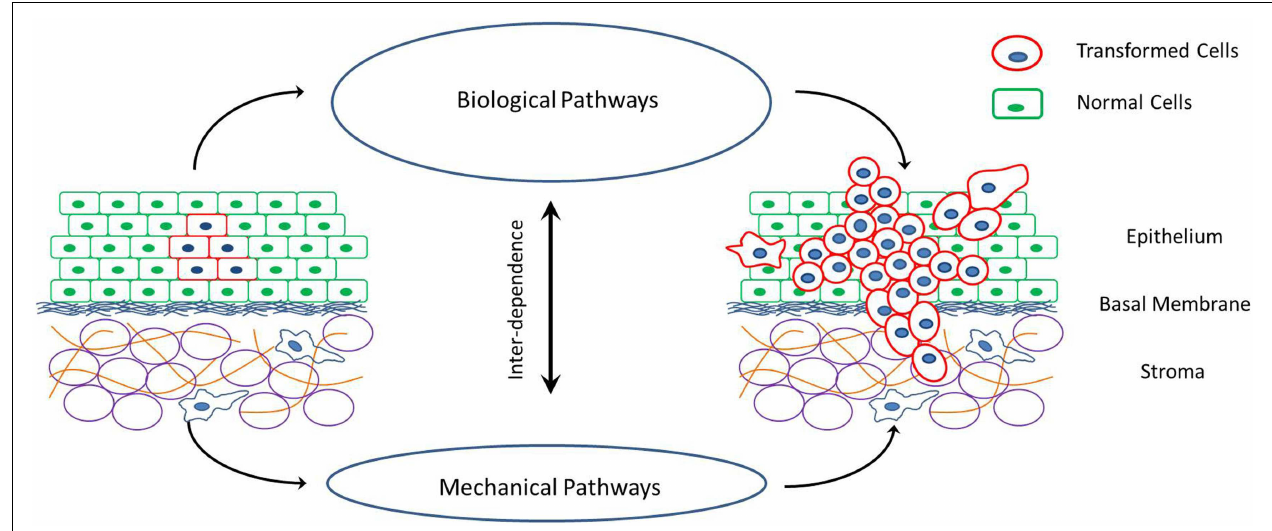
FIGURE 1 | Schematic of cancer progression in a tissue, and the interplay between the mechanical and biological factors that drive these processes of cell proliferation, invasion of surrounding tissue and metastasis via individual or collective cell migration